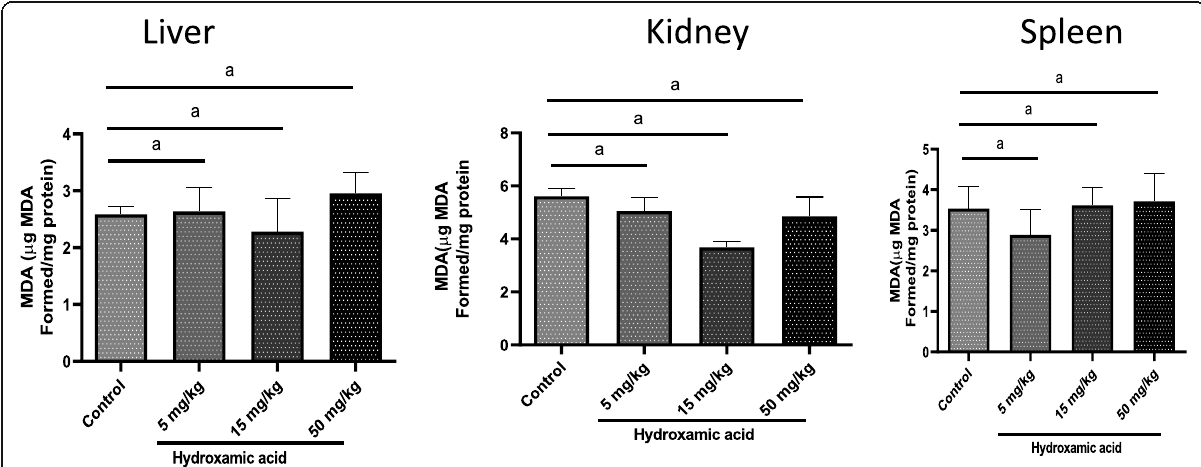
Fig. 6 Malondialdehyde level in liver, kidney, and spleen. Values are expressed as mean ± SEM; ( n = 5).Different letters indicate significant difference at p <